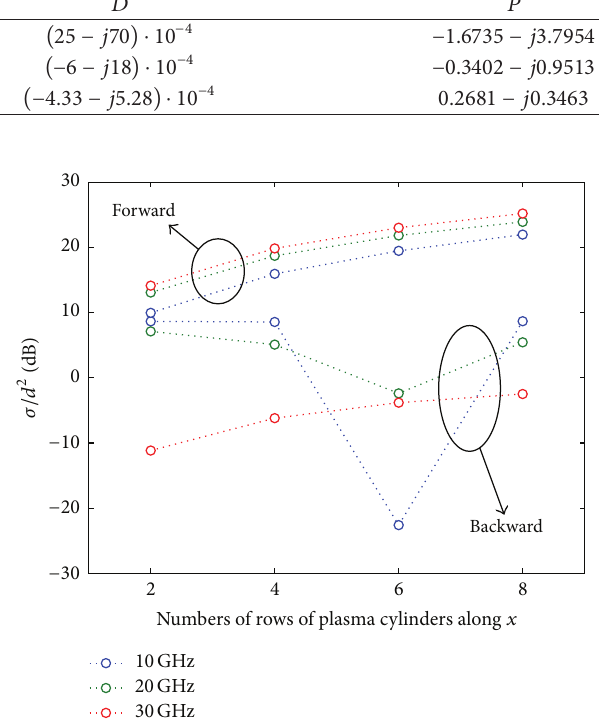
Figure 8: Modelling arrays of microplasma rods with LEGO: (a) volumetric mesh of a rod; (b) surface mesh of the brick that embeds the rod. Data : rod’s diameter 1mm, rod’s height 10mm, brick’s width 2.5 mm, brick’s height 11.5mm, 𝑁 𝑂 = 1876 , and 2𝑁 𝐹 = 1056 . the 𝑥 -axis for an 𝑥 -directed 𝑧 -polarized incident plane wave.